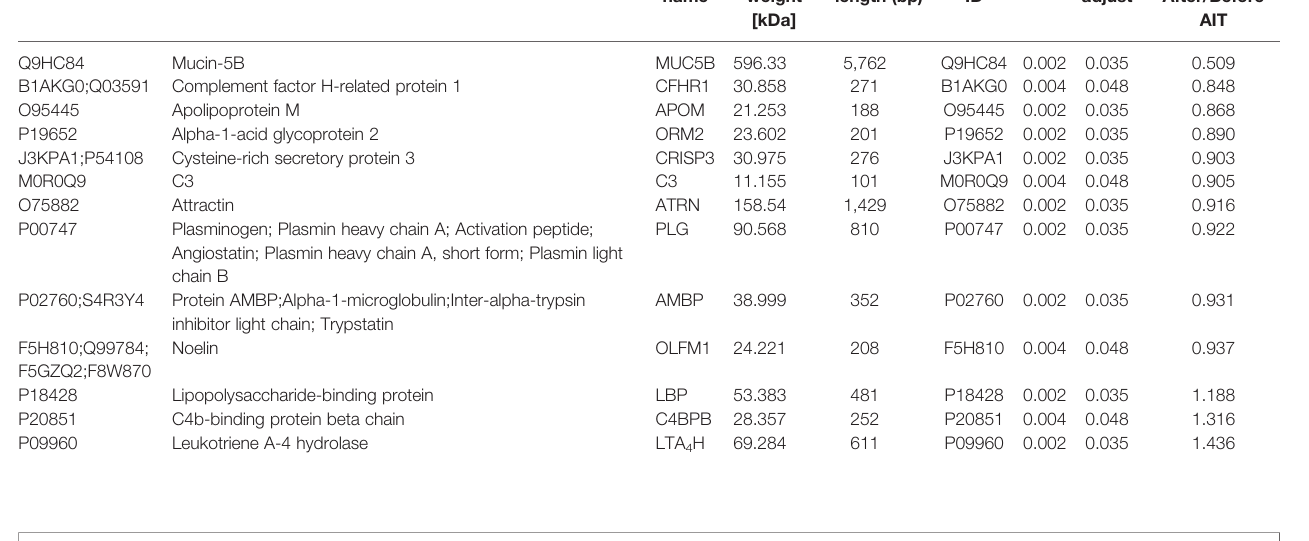
TABLE 3 | Serum proteins with signi fi cant change of expression levels after 1-year treatment. Protein ID